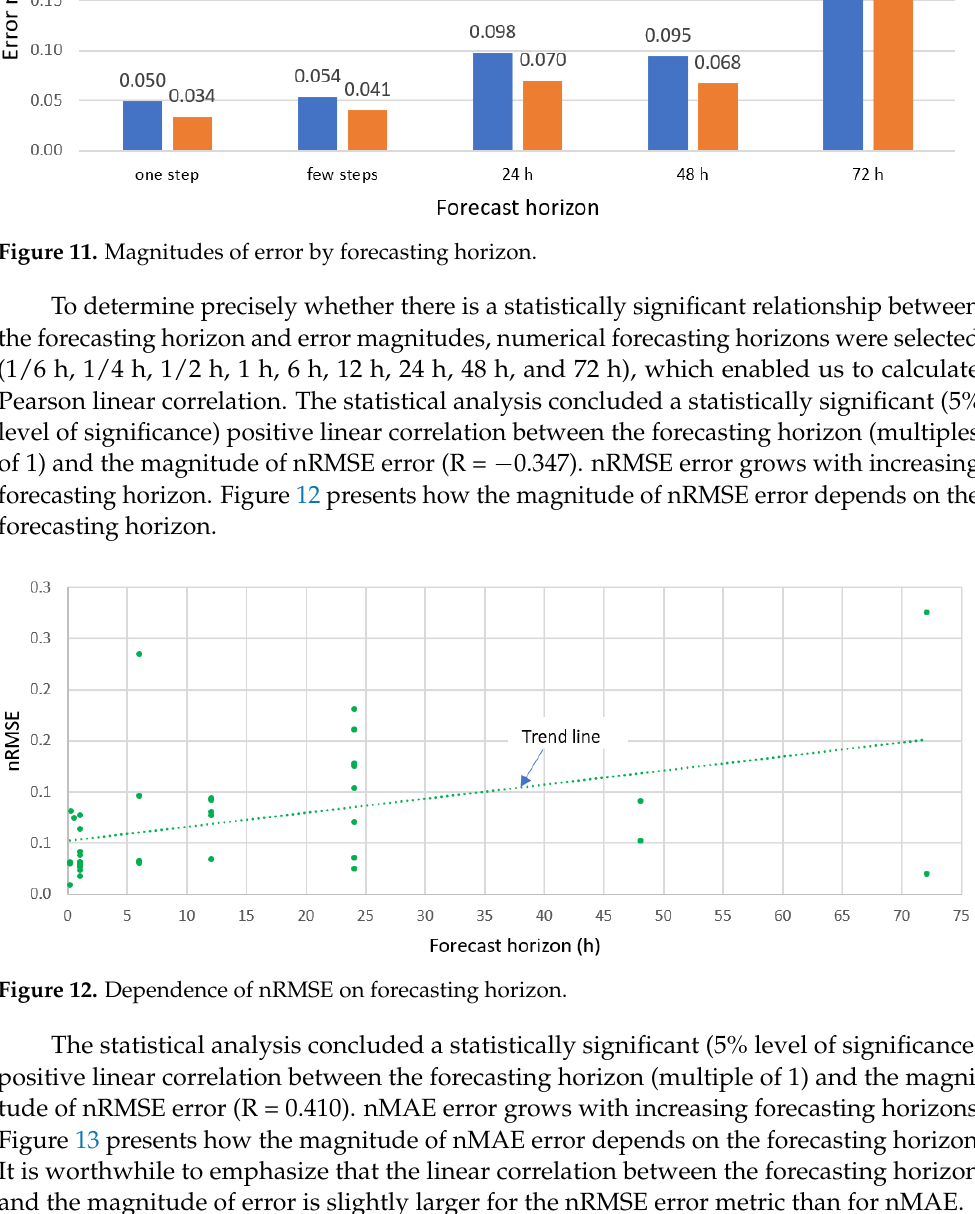
Figure 13. Dependence of nMAE errors on forecasting horizon. The statistical analysis concluded a statistically insignificant (5% level of significance) negative linear correlation between the forecasting horizon and EDF (R = − 0.196). The EDF slightly decreases with increasing forecasting horizon. Figure 14 presents how EDF de- pends on the forecasting horizon. For forecasts with very short horizons (from 10 min to 1 h), the average EDF is 1.422, and 1.3163 for 6 h, and it falls to 1.2724 for the 24 h horizon. For the 48 h and 72 h horizons, the samples are too few to calculate reliable averages. In addition, statistical analysis omitting the 48 h and 72 h horizons concluded a neg- ative correlation. Not a very large one, but statistically significant (15% level of signifi- cance), between the forecasting horizon and EDF (R = − 0.283).